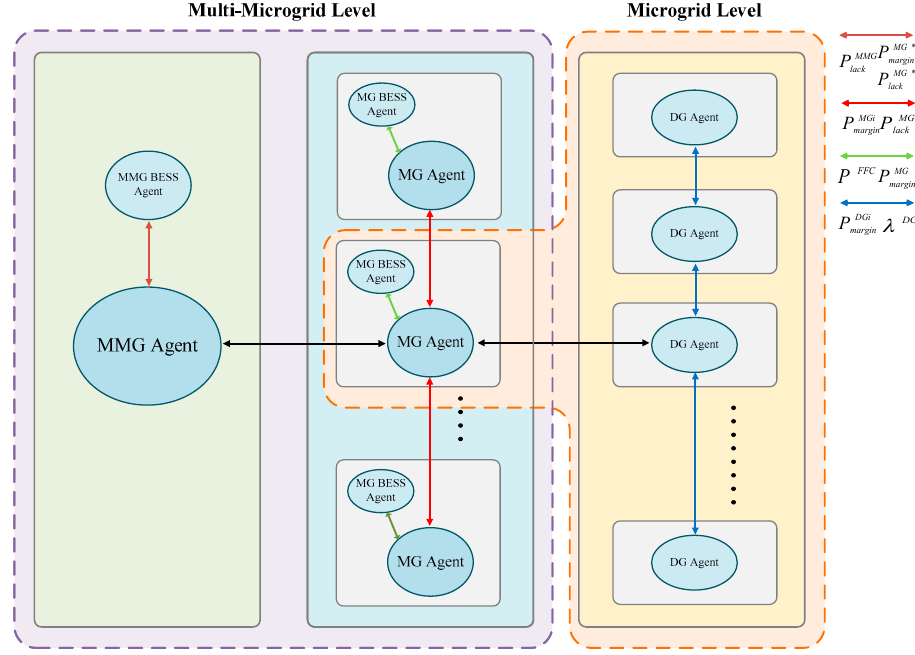
Figure 2. Concept of distributed control for a MMG.